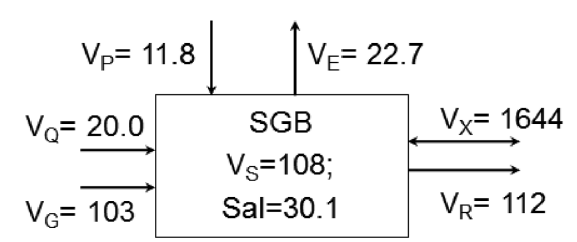
Fig. 8. Water and salt budgets for Sanggou Bay (SGB). Units: water volume, 10 7 m 3 ; water and salt fluxes, 10 7 m 3 and 10 7 psu m 3 mo −1 , respectively. V Q , V P , V E , V G , V S , V R , and V X are the mean flow rate of river water, precipitation, evaporation, groundwater, the volume of the system of interest, the residual flow, and the mixing flow between the system of interest and the adjacent system, respectively. For comparison, salinity of the adjacent system =